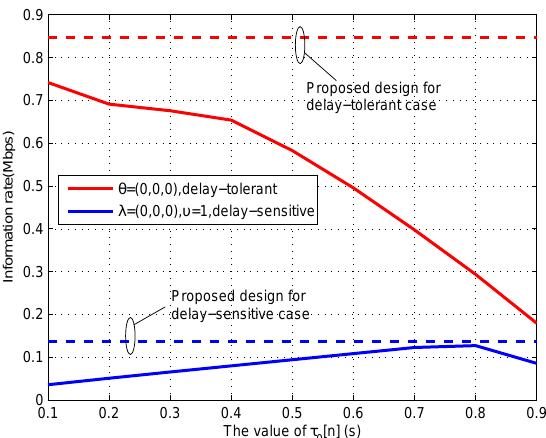
Figure 10. The transmit rate under fixed energy harvesting duration τ 0 [ n ] for period T = 60